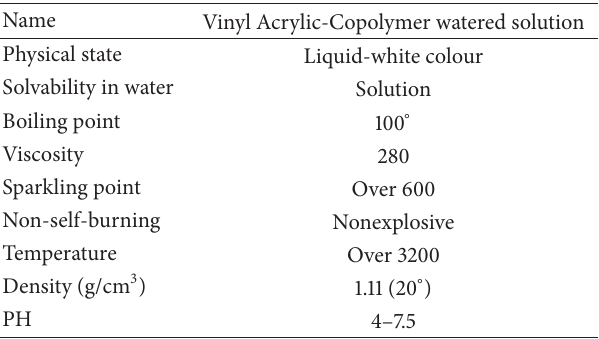
Table 2: Important physicochemical properties of as-received emulsion.